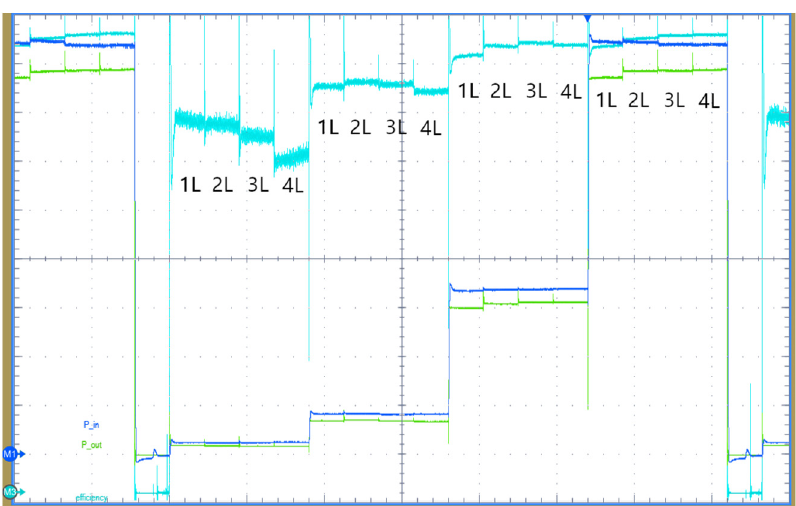
Figure 12. Experimental setup illustration.